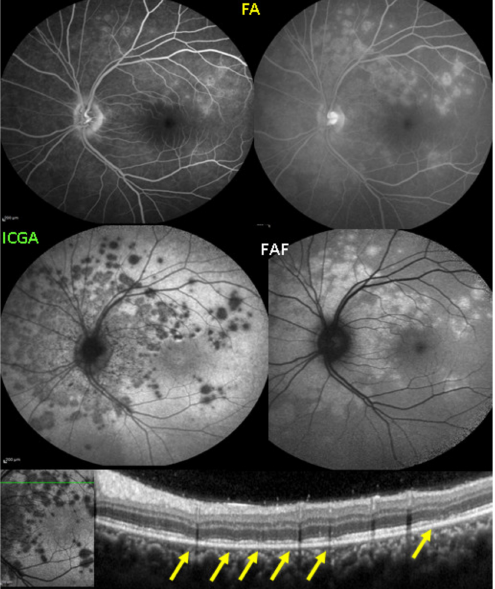
Figure 8. SD-OCT in a case of MEWDS. Loss of ellipsoid zone (photoreceptor outer segments (arrows) corresponding to the area where BAF hyperautofluorescence and ICGA hypofluorescence are